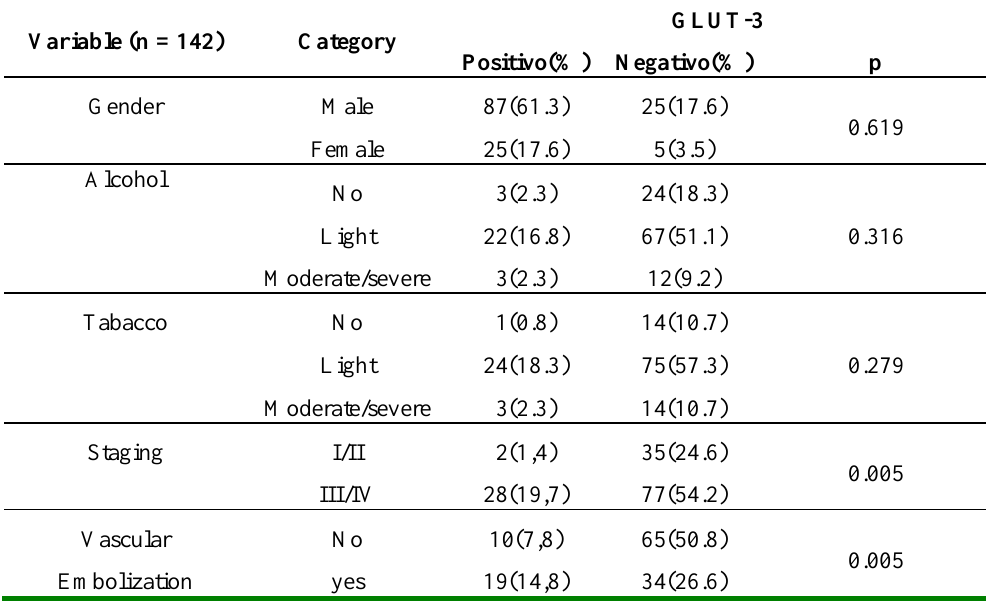
Table 3. Association between GLUT3 expression and clinic-pathological feature in OSCC. Variable (n =